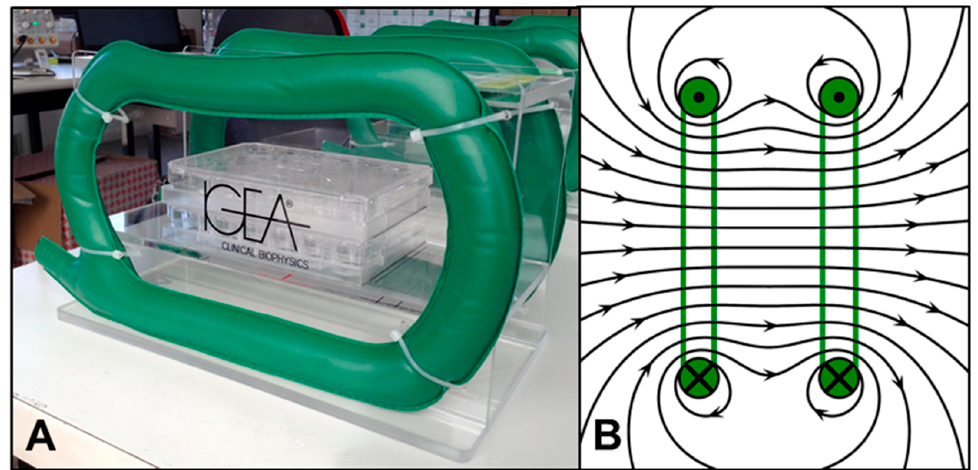
Figure 1. In vitro PEMF chamber consisting of ( A ) two electromagnetic Helmholtz coils (green) that create a ( B ) uniform magnetic field in the culture region.